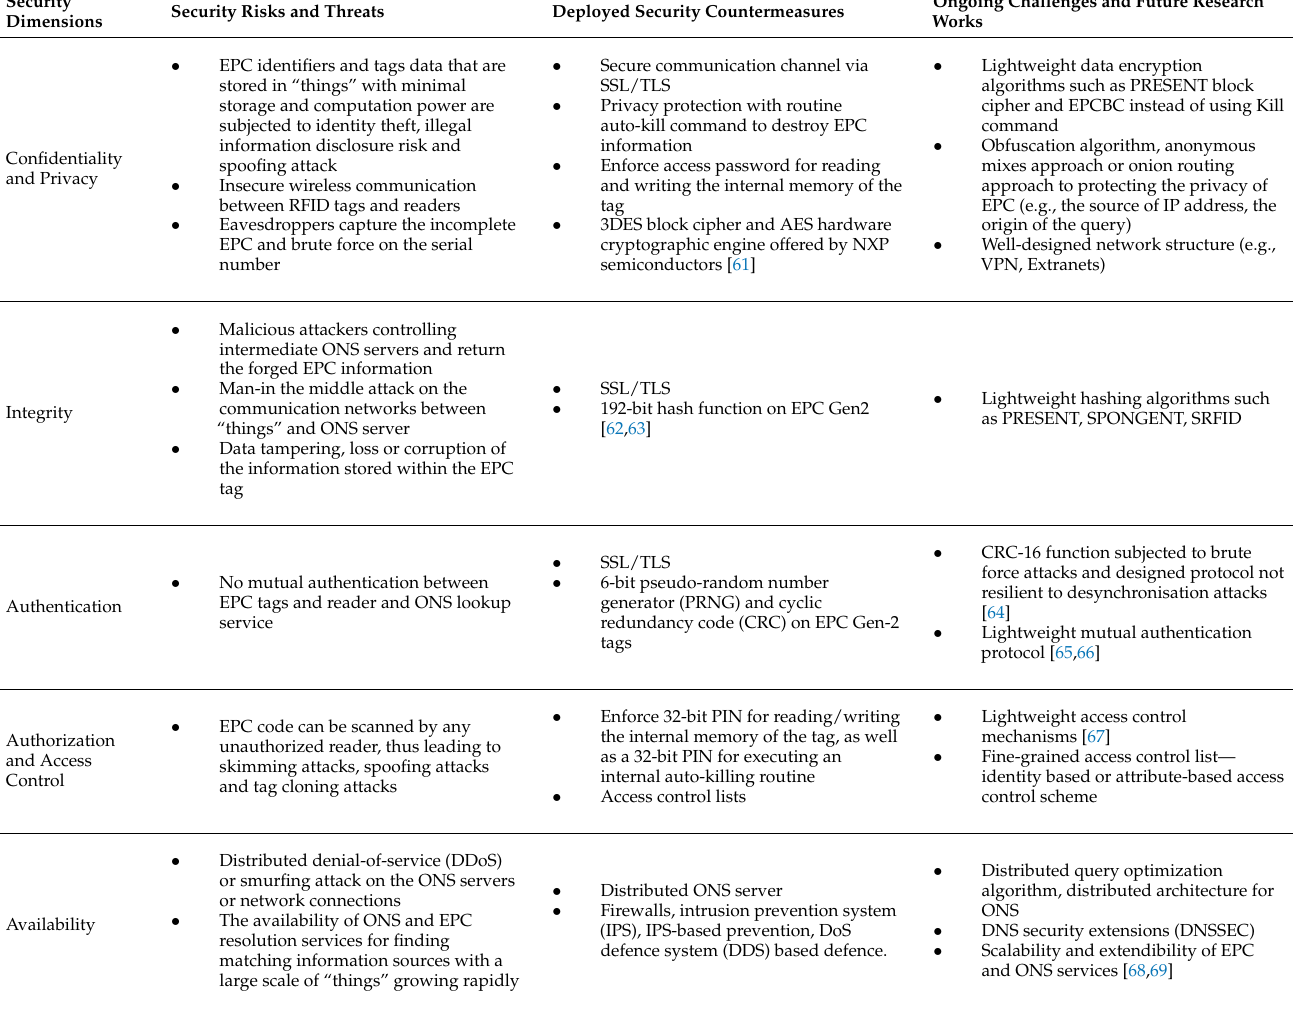
Table 4. Security analysis on electronic product code (EPC) and its object naming service (ONS) architecture. Security